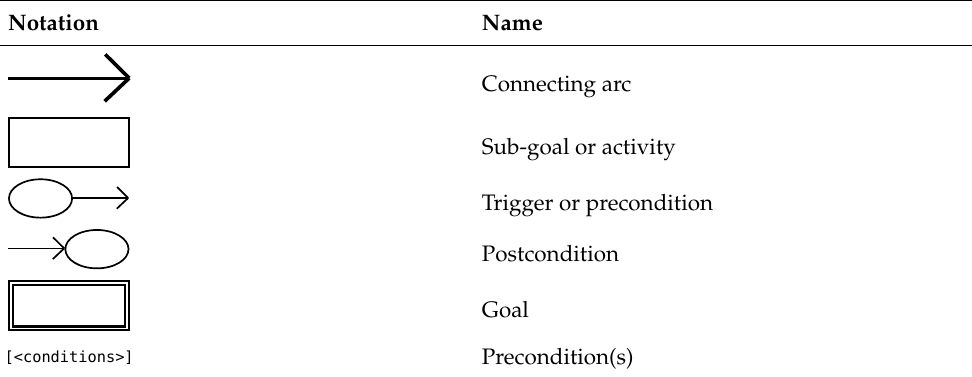
Table 3. Notation for mapping AOM to CPN (Adapted from [41]).